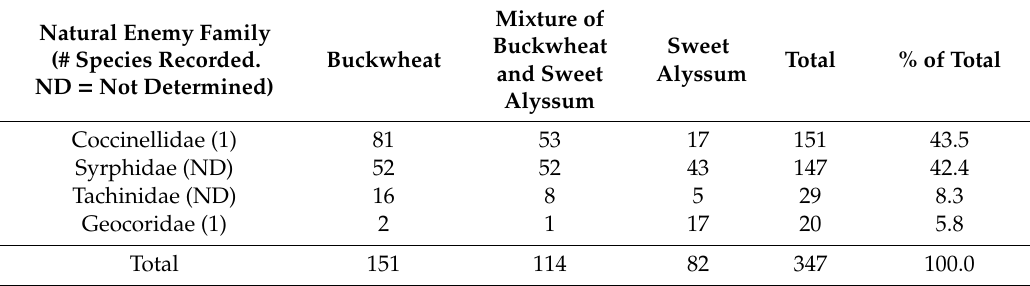
Table 1. Number of natural enemy individuals visiting insectary plant species recorded during visual observations according to insectary plant species and arrangement.